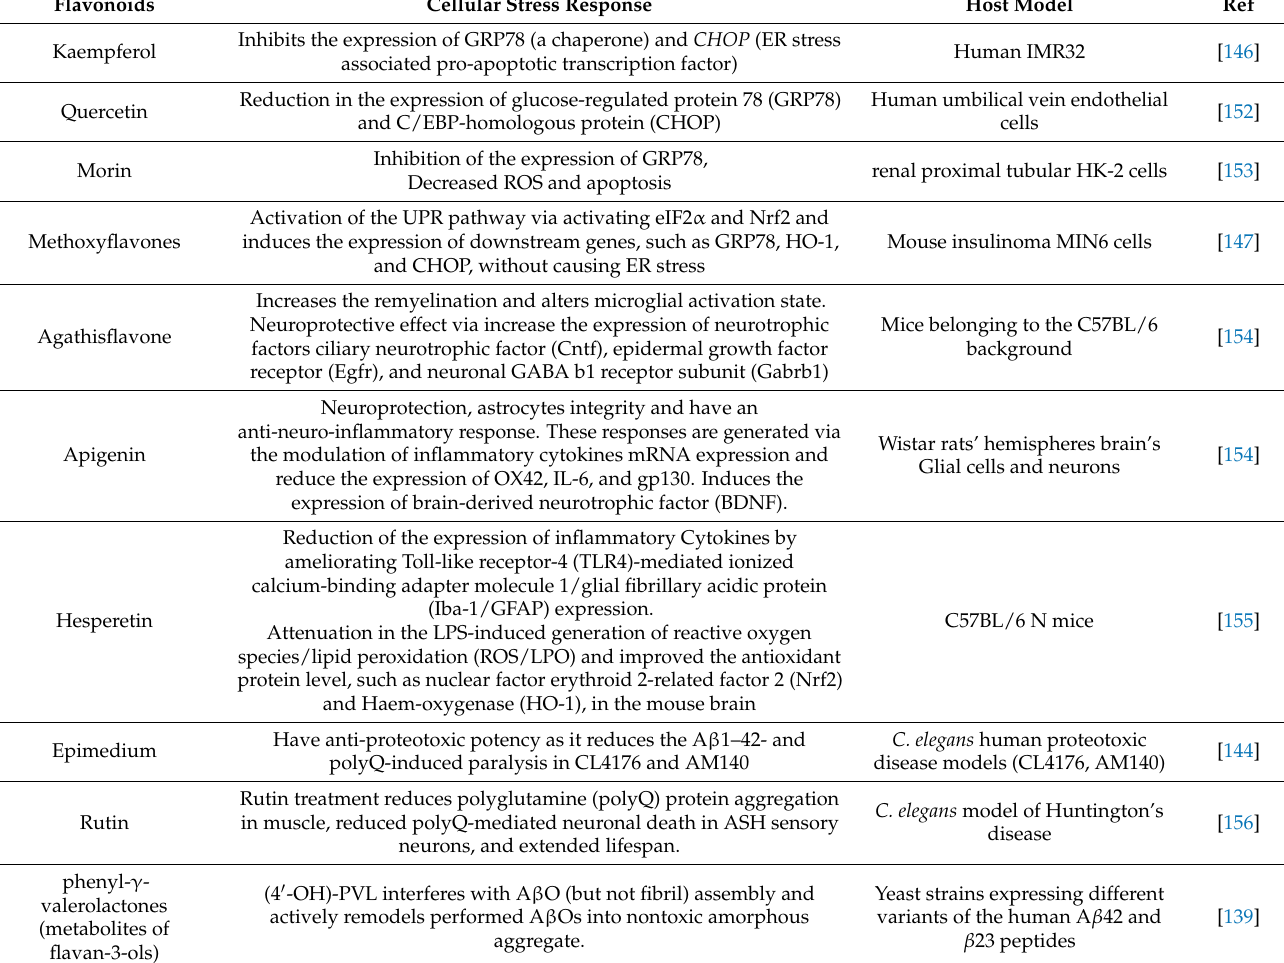
Table 2. Effect of flavonoids on the cellular stress